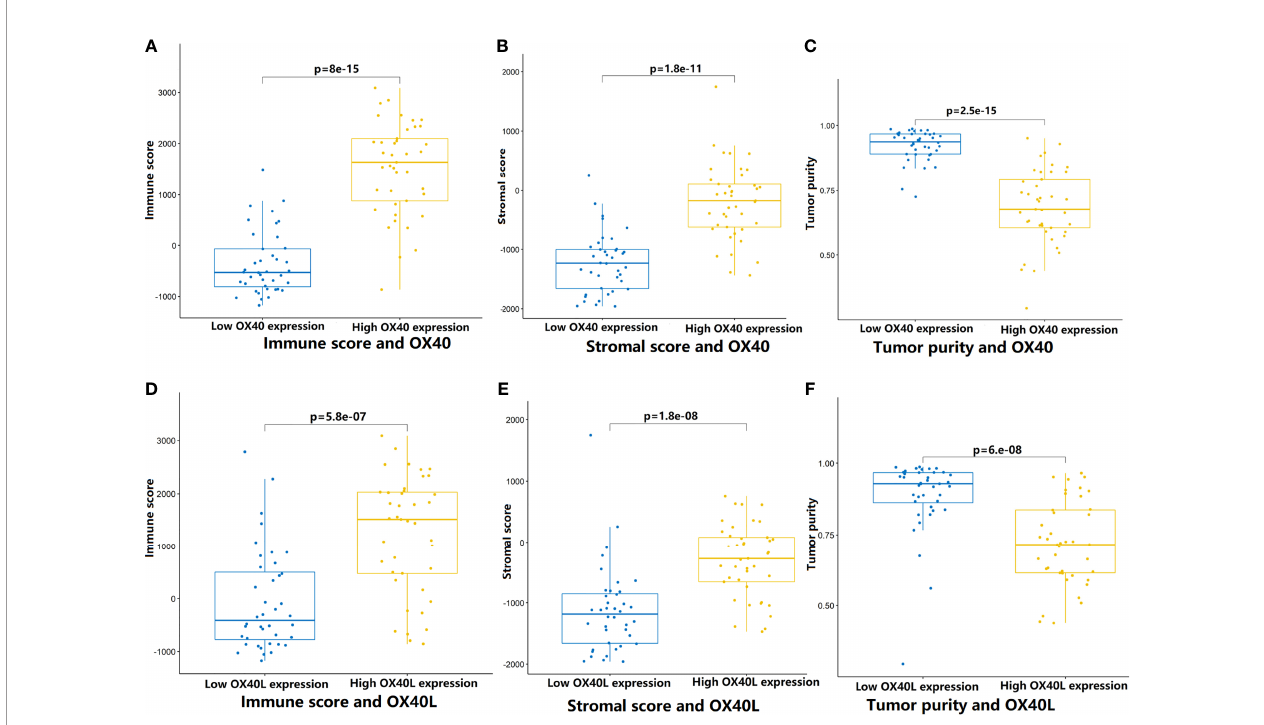
FIGURE 5 | Comparison of tumor microenvironment features that mediated by OX40/0X40L in SCLC. (A – C) By the ESTIMATE algorithm, the differences of immune score, stromal score, and tumor purity between the high and low OX40 expression groups. (D – F) Comparison of immune score, stromal score, and tumor purity between the high and low OX40L expression groups. SCLC, small cell lung cancer; OX40L, OX40